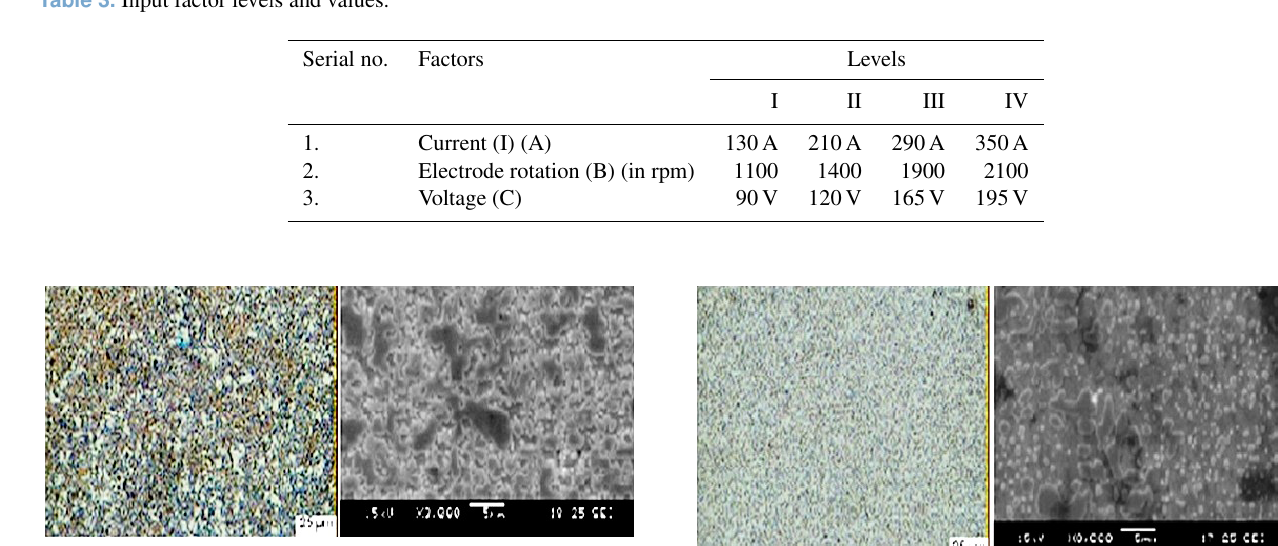
Table 3. Input factor levels and values.